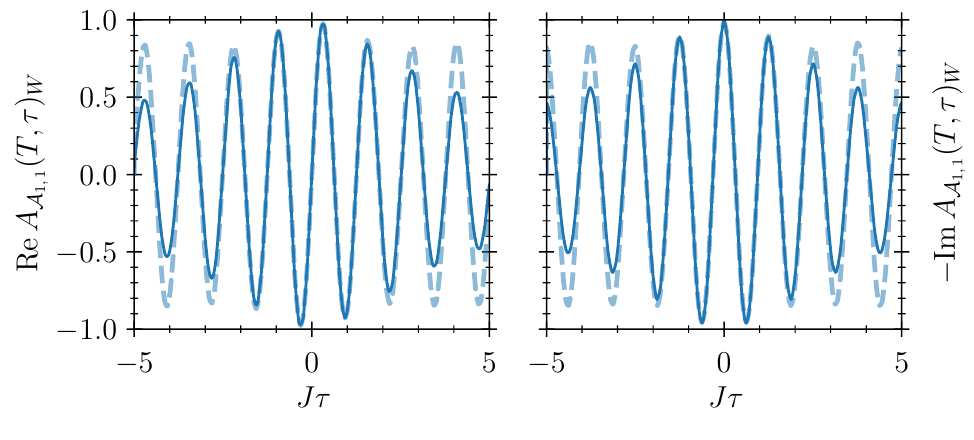
(cid:148) (cid:151) > < ( T , τ ) = ( T , τ ) − ( T , τ ) for the A 1,1 W W W 1,1 1,1 A A